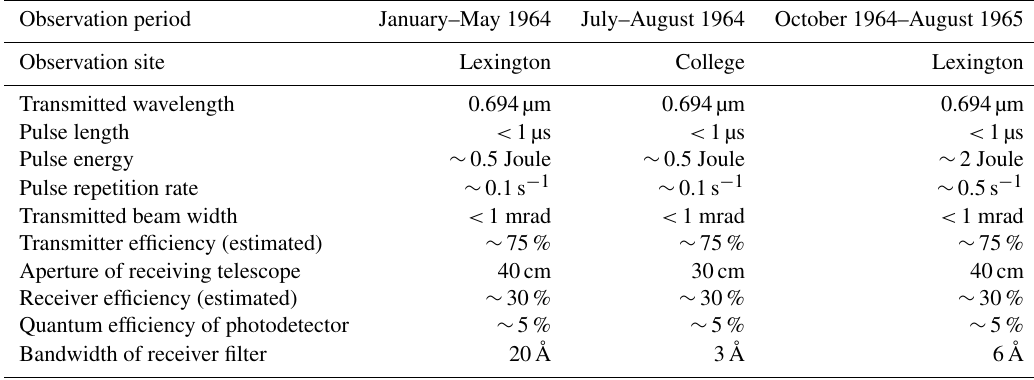
Table 1. Technical features of the lidars operated at Lexington and College, Fairbanks. Observation